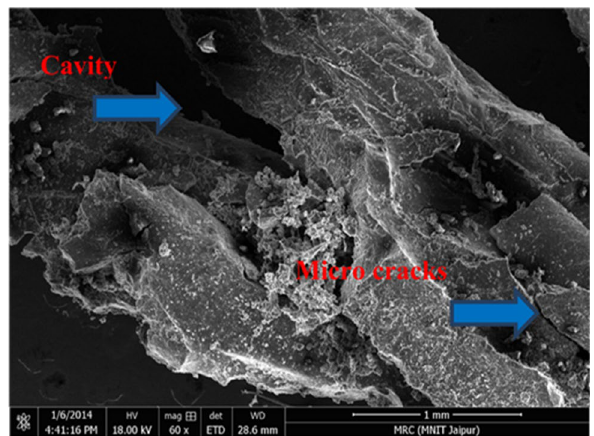
Fig. 20 SEM image of rubber fiber at 60 × magnification